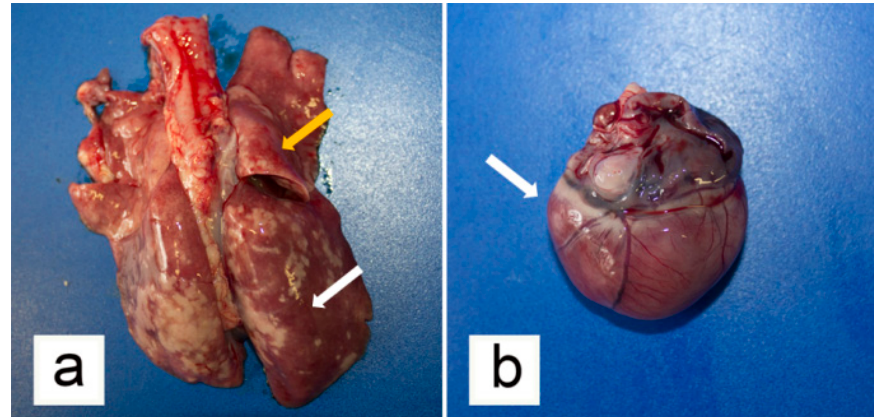
Figure 4. Gross pathological findings from the examined kitten. ( a ) Lungs showed diffuse hyperaemia (orange arrow) with lobular areas of consolidation (white arrow) and sparse whitish, slightly raised nodules. ( b ) Marked right-sided cardiac enlargement was evident (white arrow). At the examination of the post mortem lung lavage fluid, a countless number of L1 were evidenced. Molecular analysis of all biological samples taken from the kitten, i.e., lung lavage liquid, parasite as A. abstrusus .